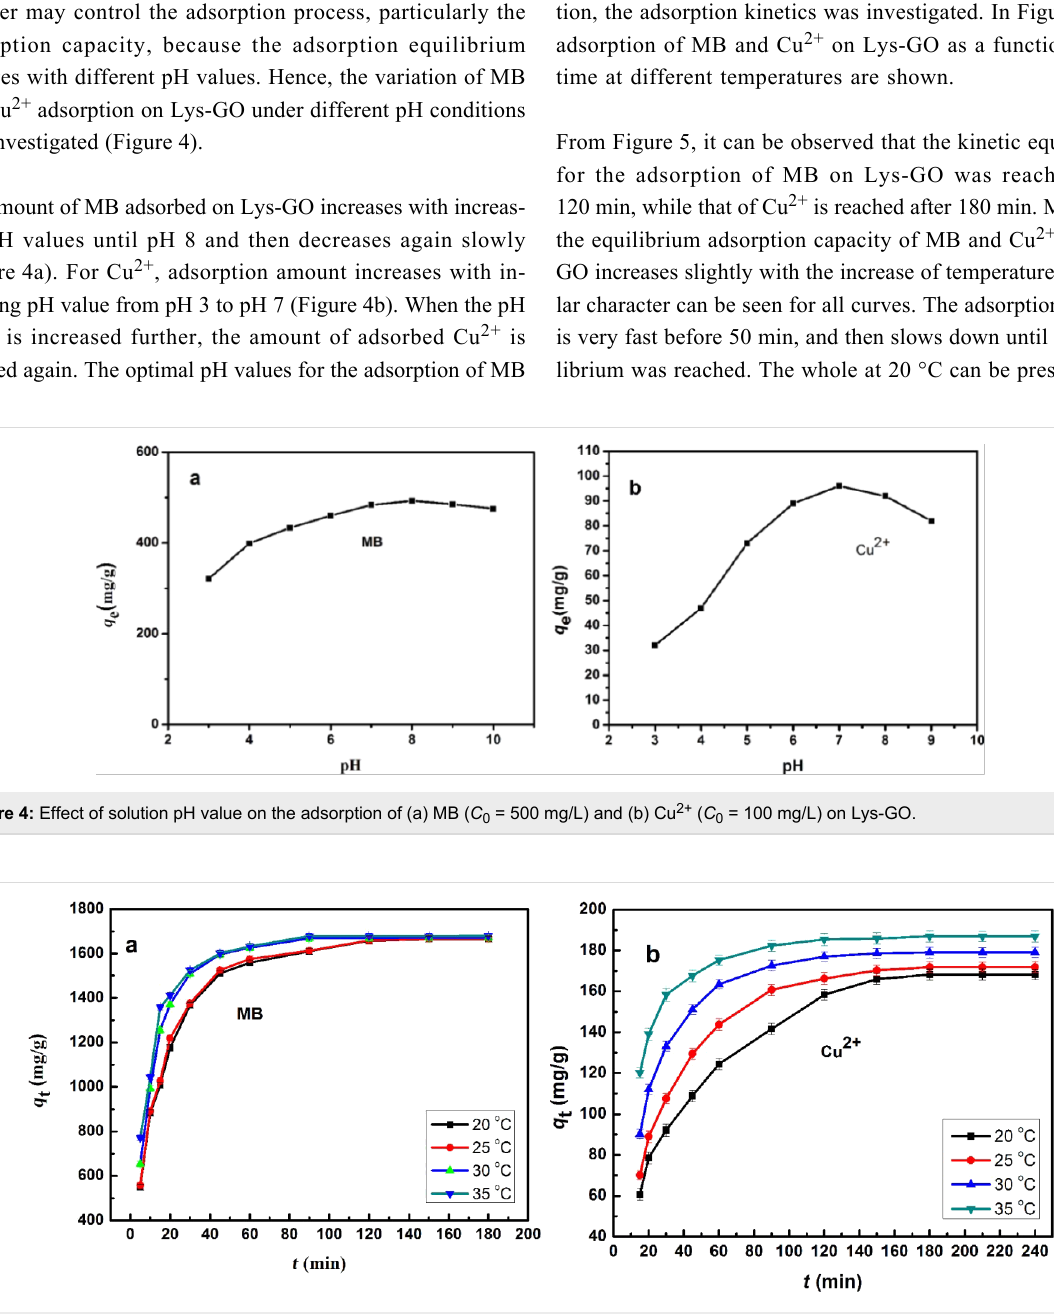
Figure 5: The adsorption of (a) MB ( C 0 = 1800 mg/L, pH 8.0) and (b) Cu 2+ ( C 0 = 200 mg/L, pH 7.0) on